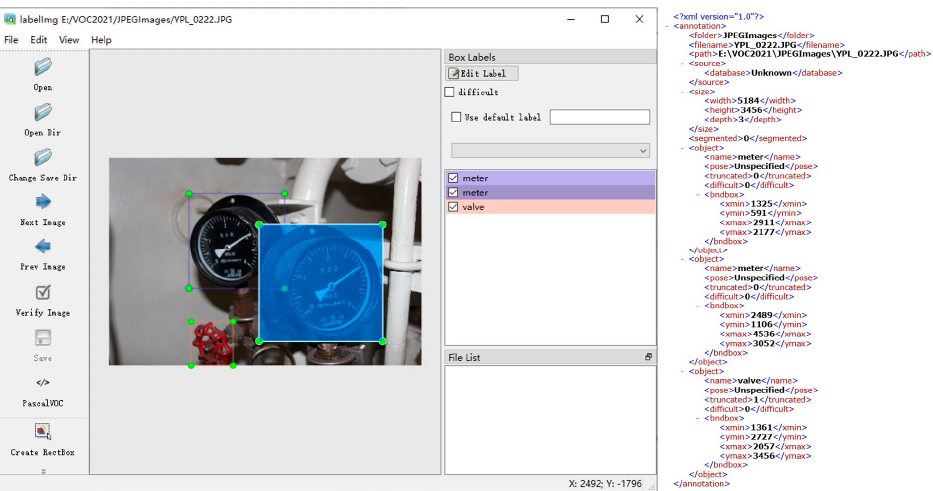
Figure 14. Example of LabelImg interface and XML.